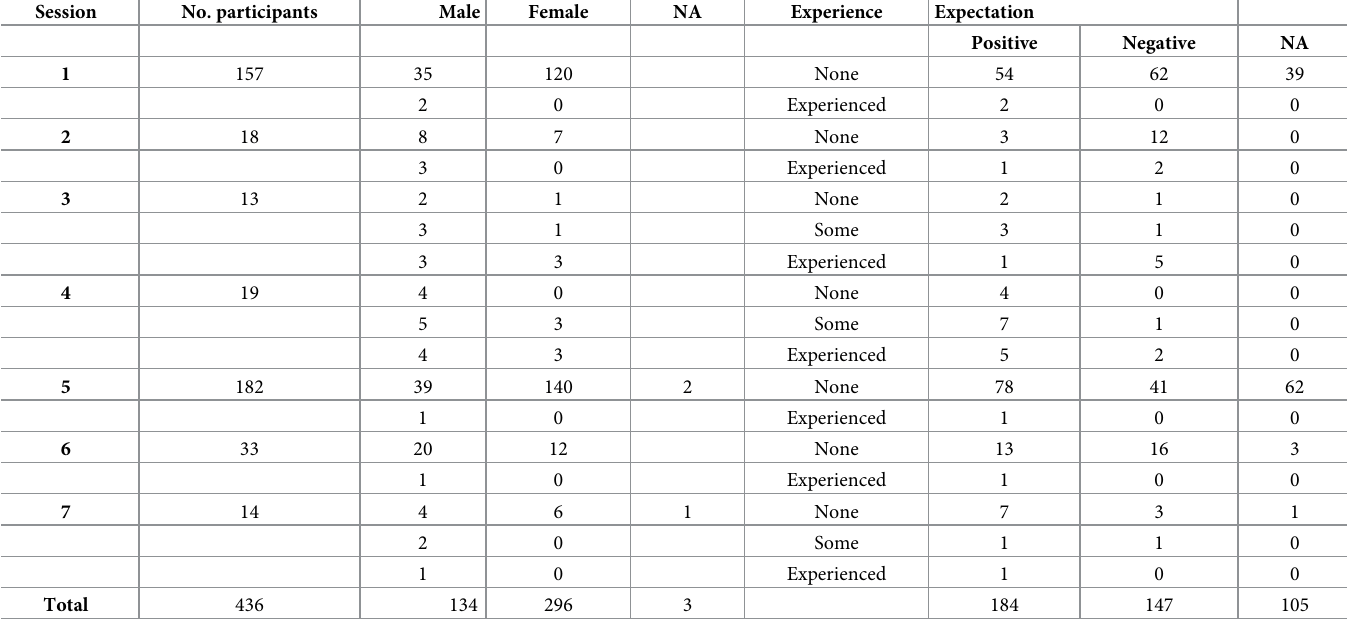
Table 3. Number, gender, experience, and expectation of workshop participants per scoring session (1–7), stratified by previous experience in scoring reflex respon- siveness of live animals (‘none’: no animals scored; ‘ some’: < 100 animals scored; and ‘experienced’: � 100 animals